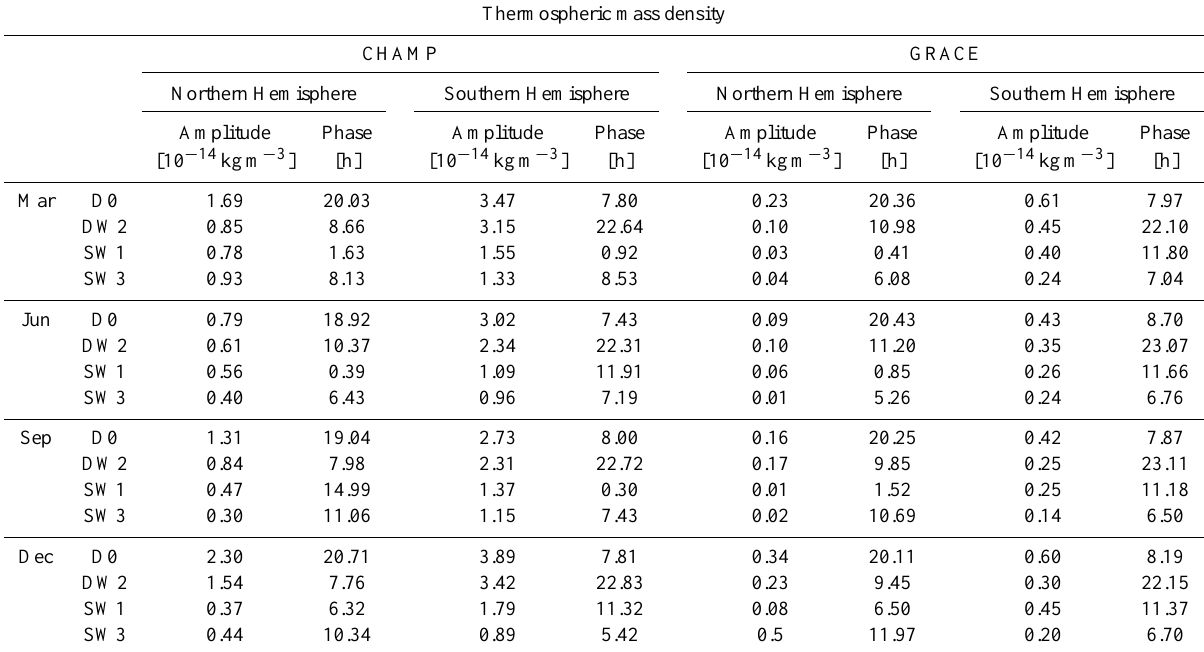
Table 1. Amplitudes and phases of diurnal tides D0 and DW2 as well as semidiurnal tides SW1 and SW3 from the thermospheric mass density measurements during the years